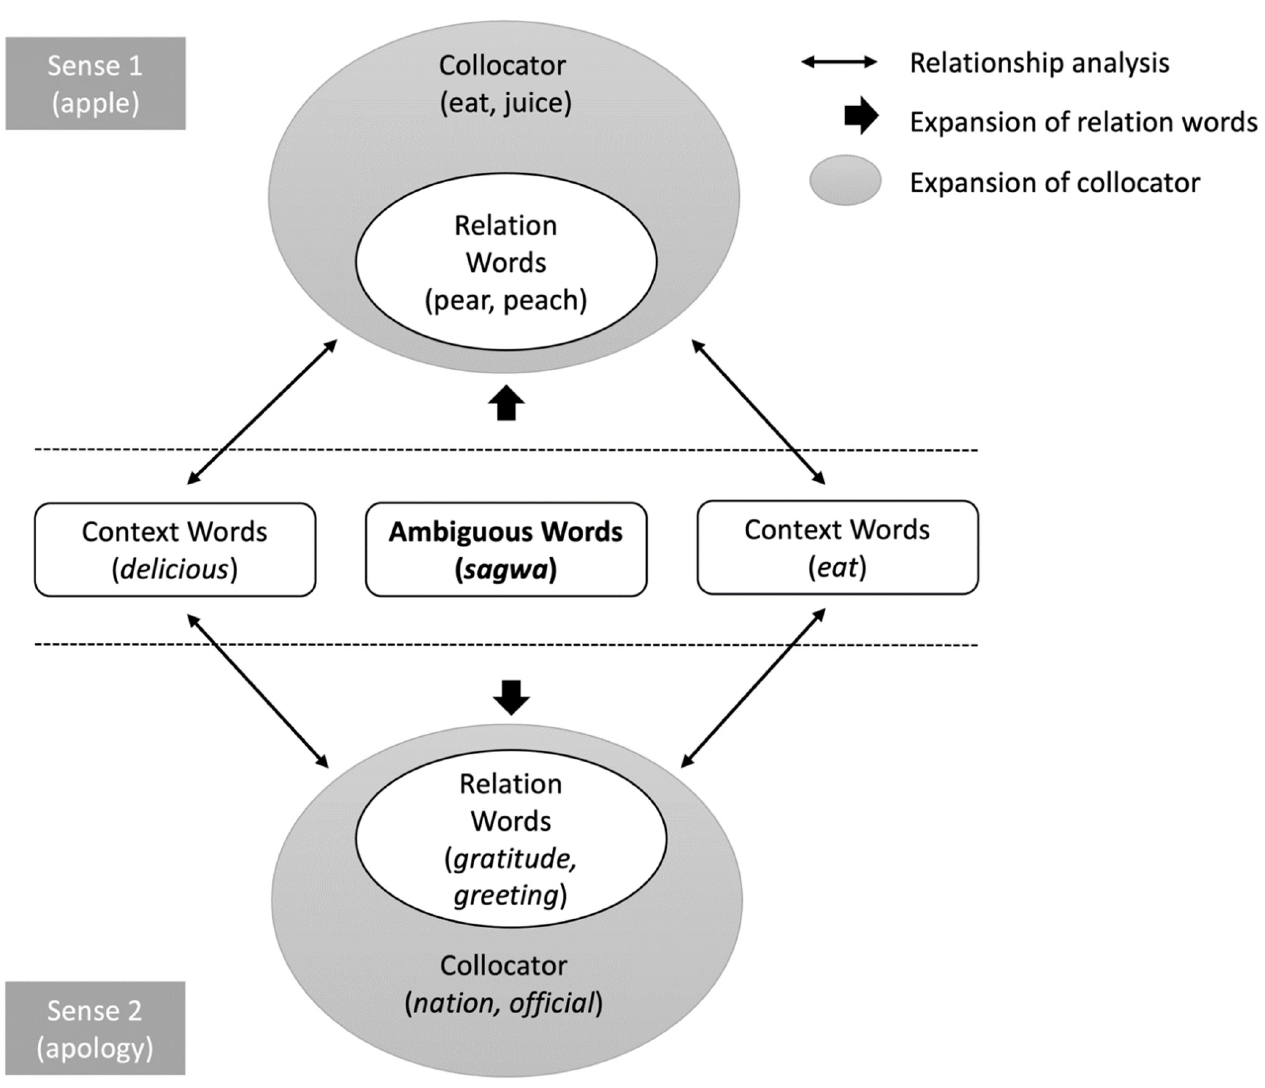
Figure 4. Relationship analysis between words using semantically related words of the ambiguous word.